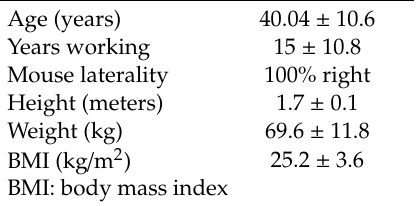
Table 1. Basal characteristics of the participants ( n = 26). Data are expressed as mean ± SD.